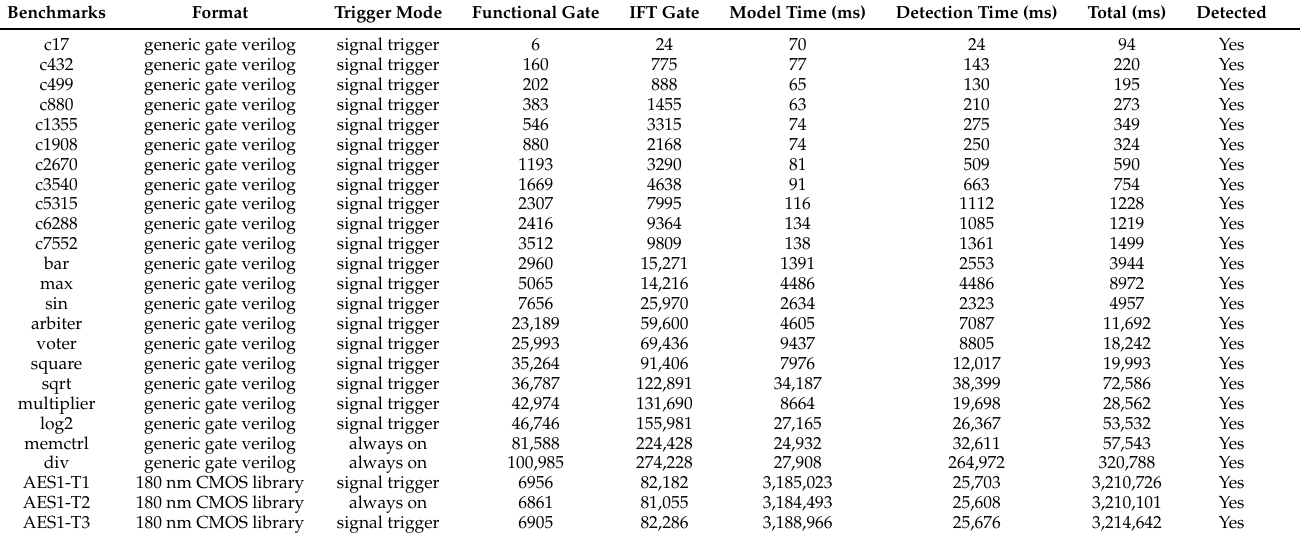
Table 2. Tests on Trojan insertion